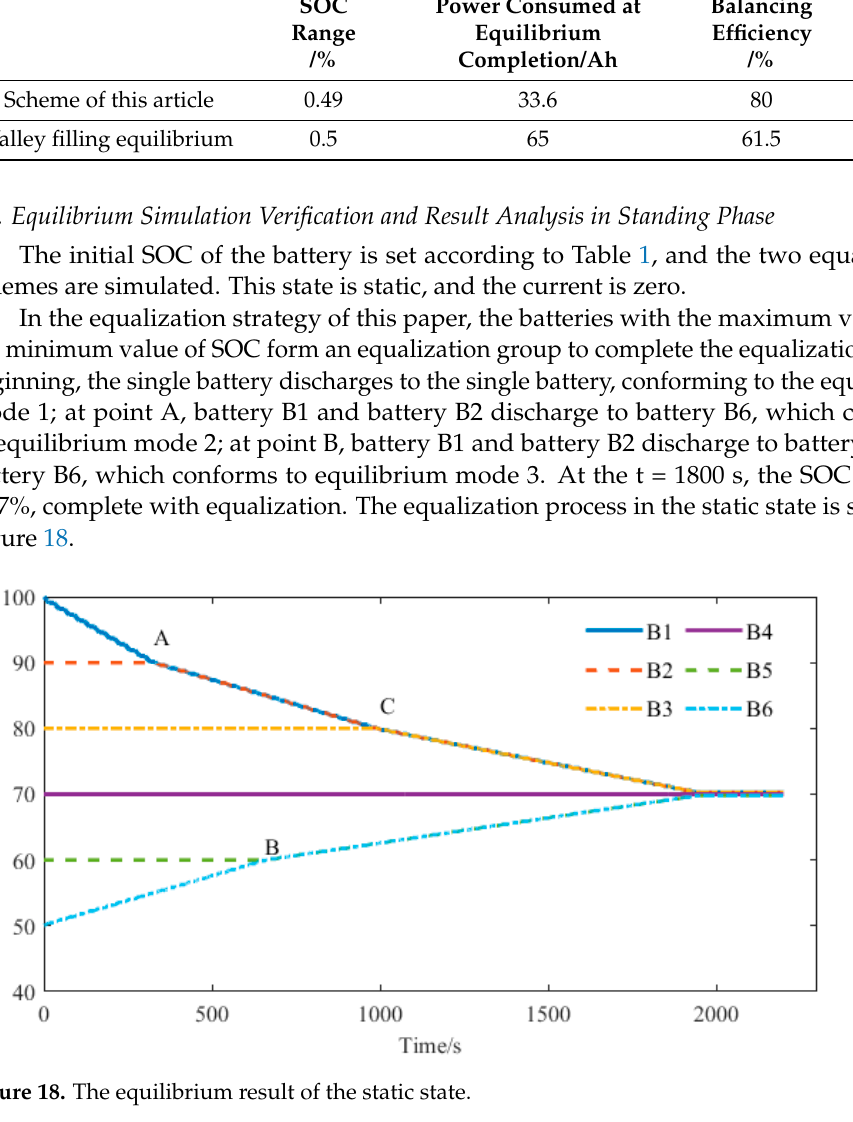
Table 5. Equilibrium result of discharging state.